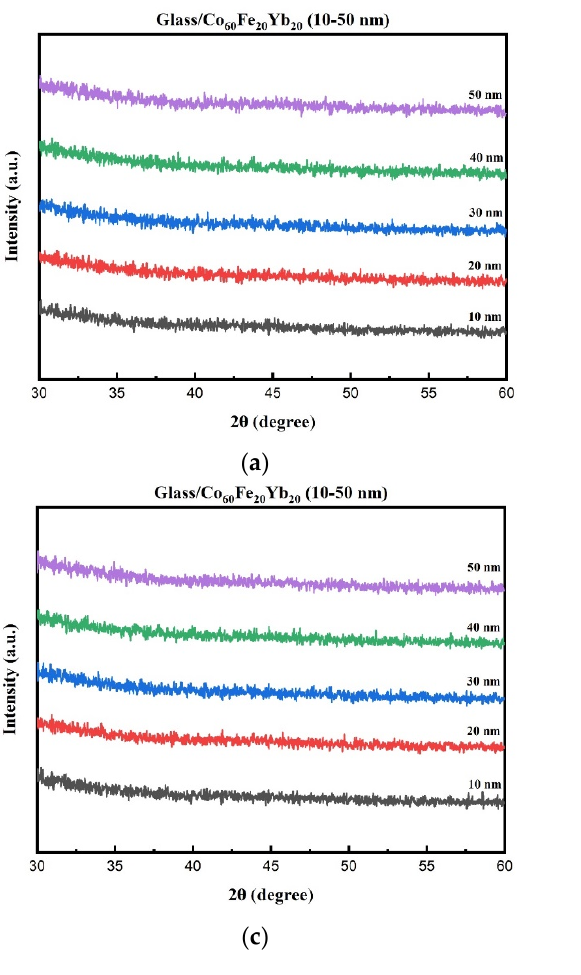
Figure 1. Thin films of CoFeYb with XRD patterns. ( a ) RT, ( b ) following annealing at 100 °C, ( c ) following annealing at 200 °C, and ( d ) following annealing at 300 °C.